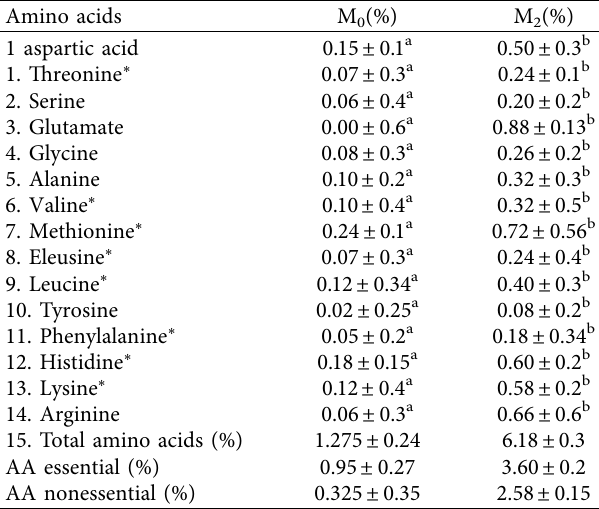
∗ amino acids essential. Description: M0 (control), M2(fish meal 8%): the different letters within the same column represent significantly different values ( p < 0 .